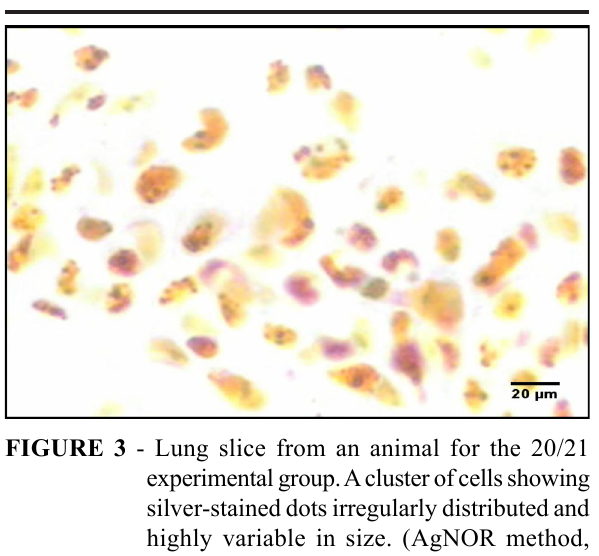
FIGURE 1 - Mean and standard deviation of 10/7 (1,51±0,86) FIGURE 2 - Mean and standard deviation of 20/7 (1,63±0,11) and 10/21 (1,84±0,13) experimental groups. and 20/21 (2,48±0,28) experimental groups.